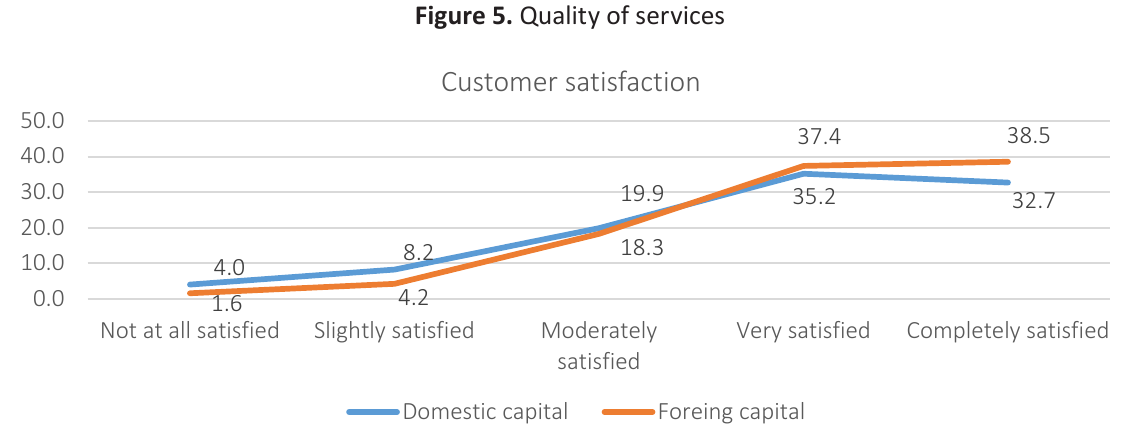
Figure 5. Quality of services